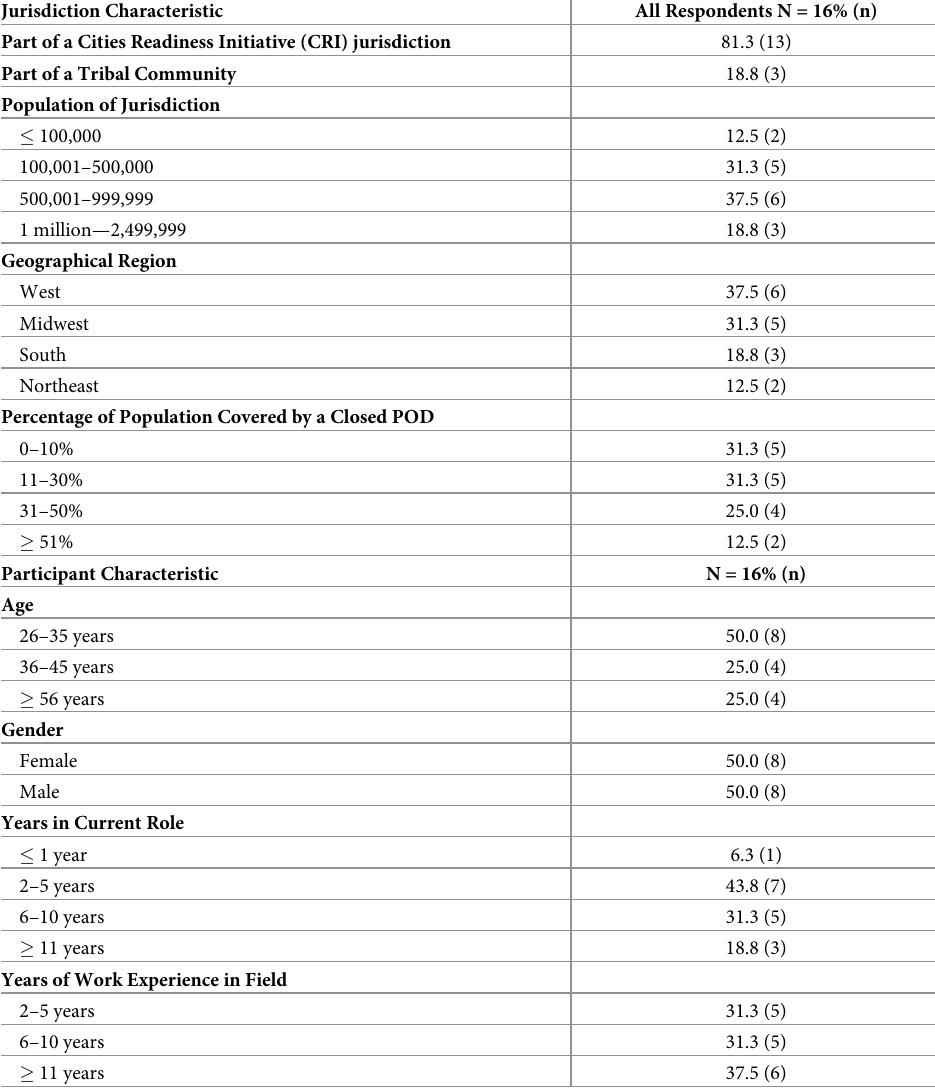
Table 1. Jurisdiction and participant